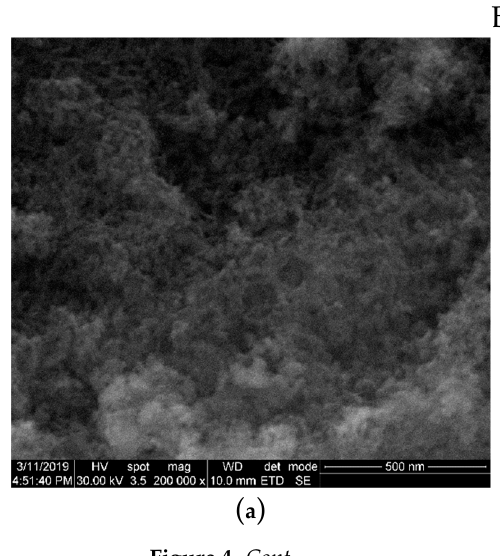
Figure 3. The estimated crystallite size, lattice microstrain and degree of crystallinity.